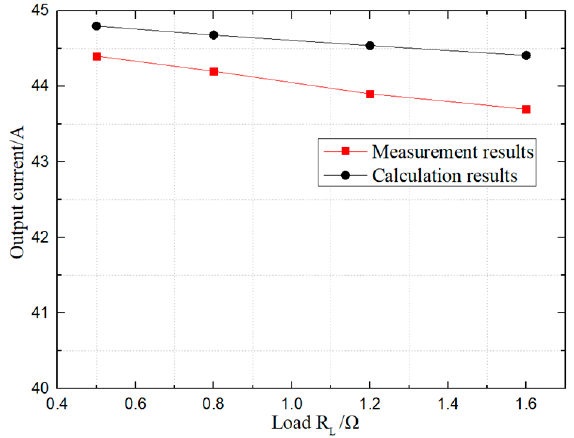
Figure 27. Comparison of output current. In order to verify the relationship between the phase-shift angle and the output current in Chapter IV, the phase-shift angle of the synchronous rectifier in the secondary side was changed, and the output current is measured under different phase-shift angles. The curve between output current and the phase-shift angle is shown in Figure 28. When the secondary side control signal lags the primary side control signal by 90 ◦ , the secondary side output current reaches the maximum value. The relationship between output current and phase-shift angle is approximated to a sine function and the theoretical calculated value is basically consistent with the measured value, which proves the feasibility of the control